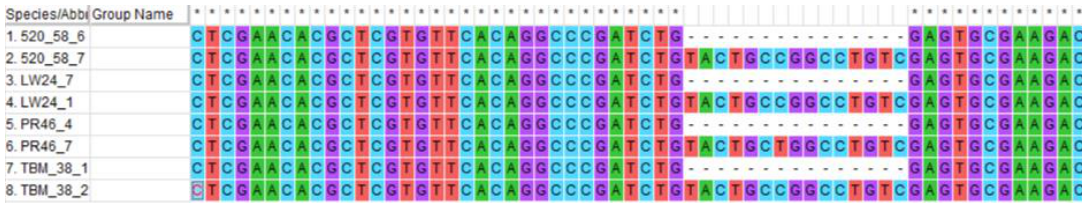
Figure 4. Two distinct variants were recovered from individual cells at all sampling sites, defined by a 15 bp deletion in one of the variants.